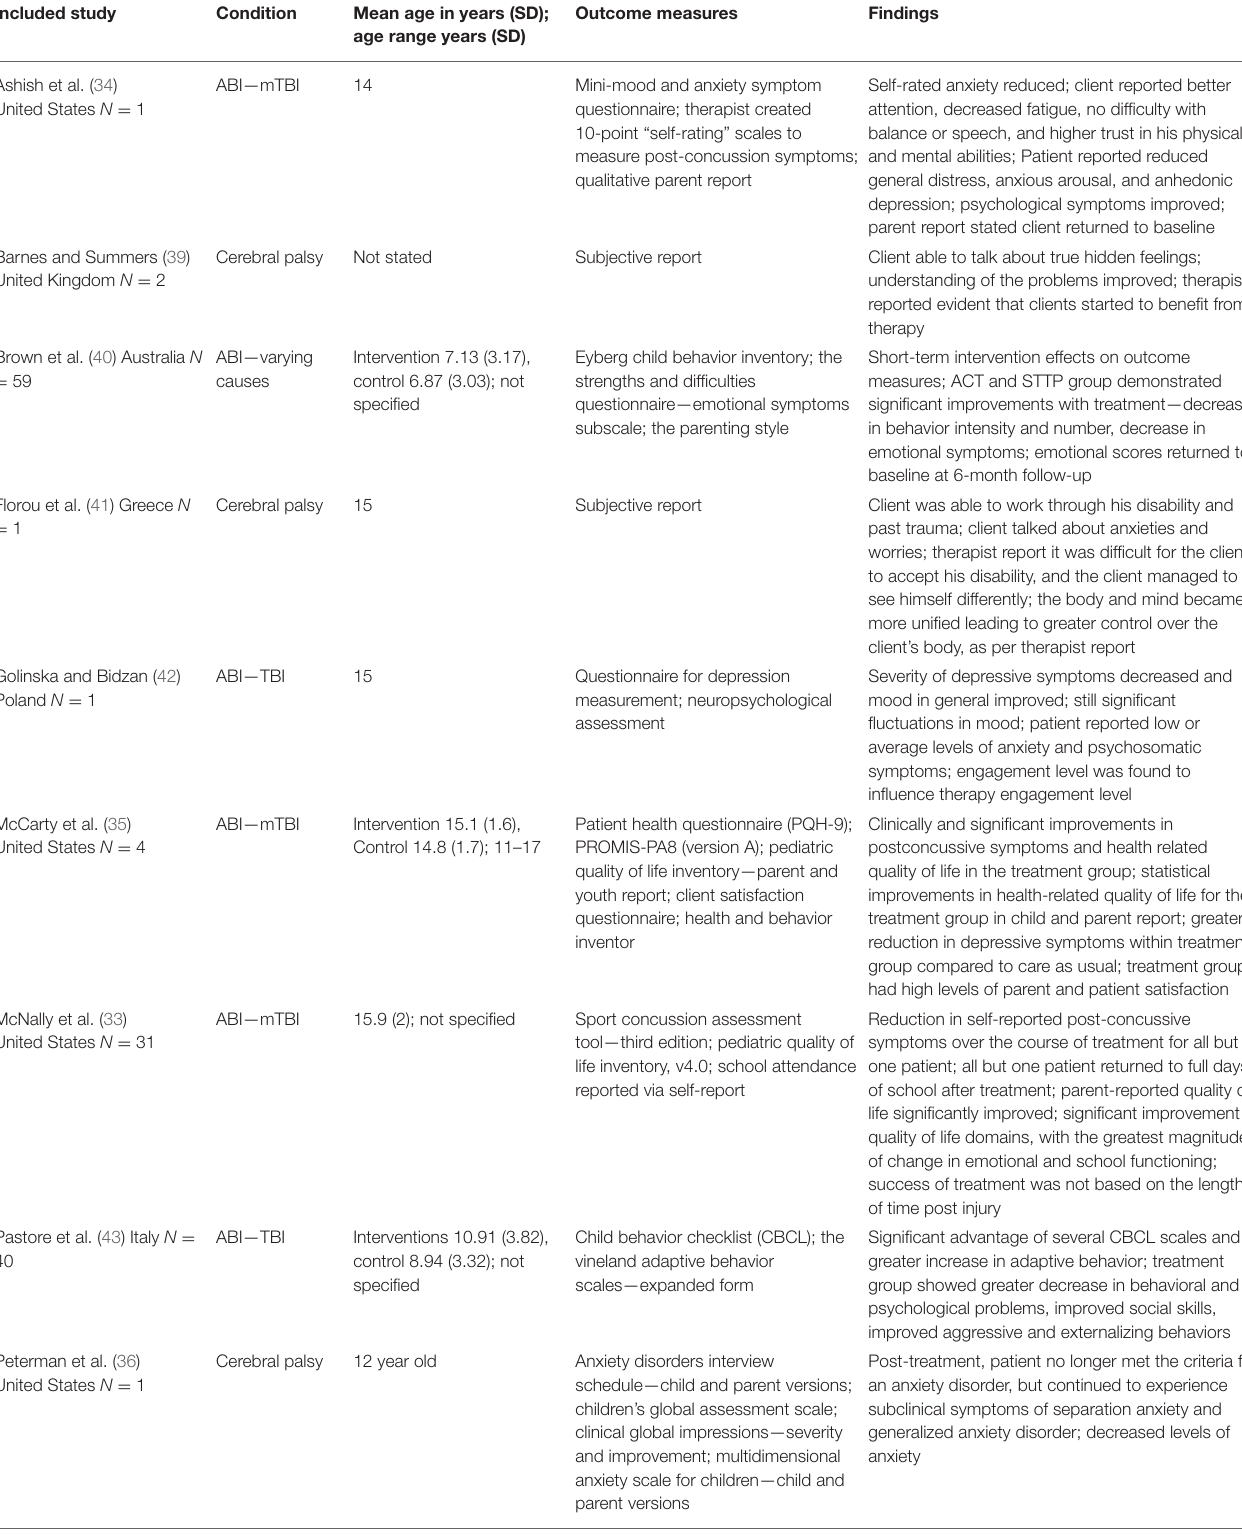
TABLE 3 | Summary of included studies’ ( n = 11) outcome measures and findings. Included